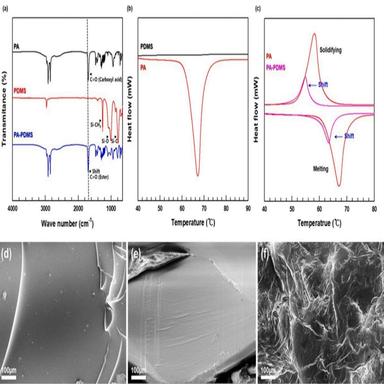
(a) FT-IR spectra and (b,c) DSC curves of matrices during fabrication of PA-PDMS. Morphologies of (d) pure PDMS, (e) palmitic acid, and (f) PA-PDMS.